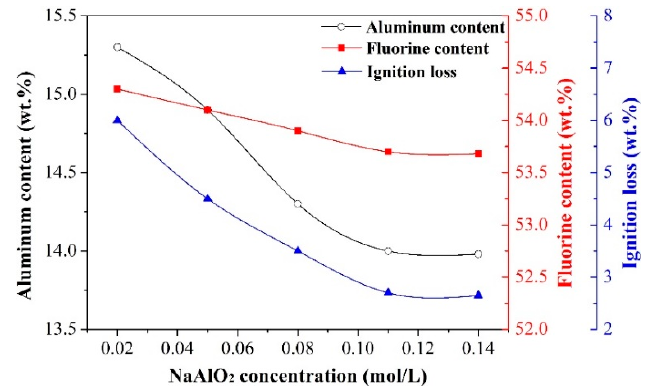
Figure 11. Effect of NaAlO 2 concentration on the aluminum content, fluorine content, and ignition loss of synthetic cryolite.